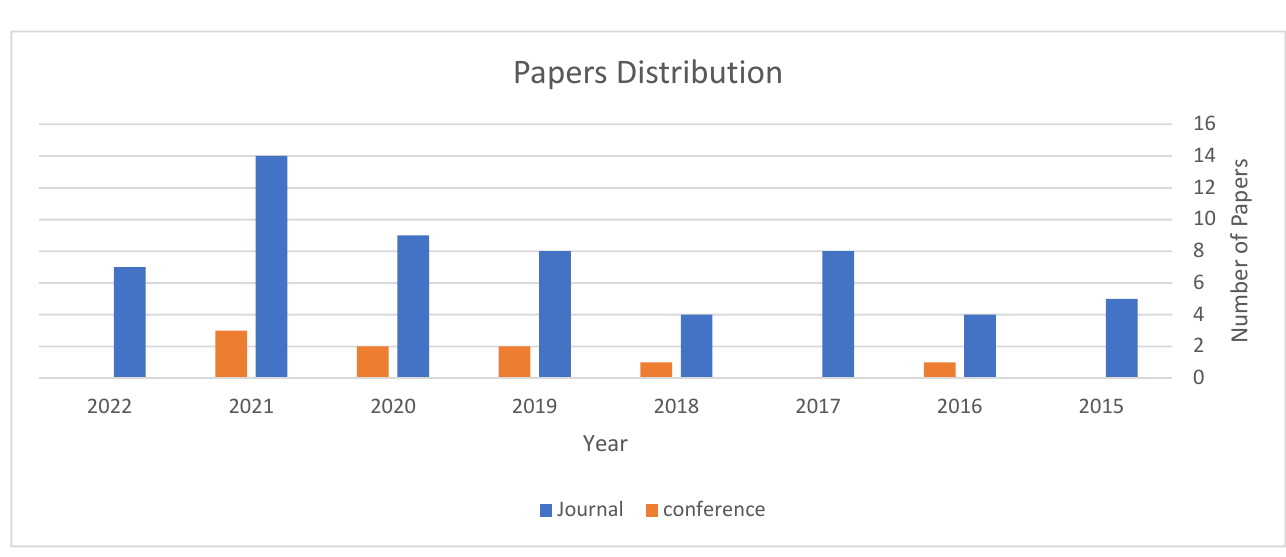
Figure 11. Papers distribution.